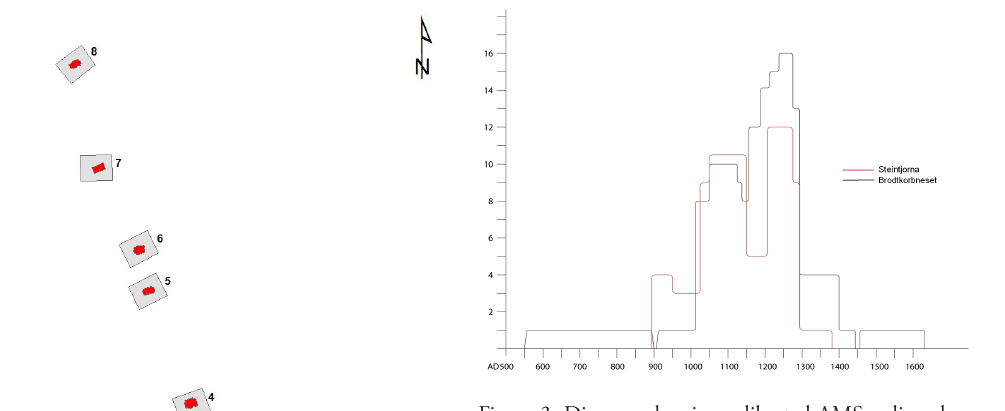
Figure 3. Diagram showing calibrated AMS radiocarbon dates from Brodtkorbneset and Steintjørna. Radiocarbon ages calibrated using OxCal 4.2 (Bronk Ramsey